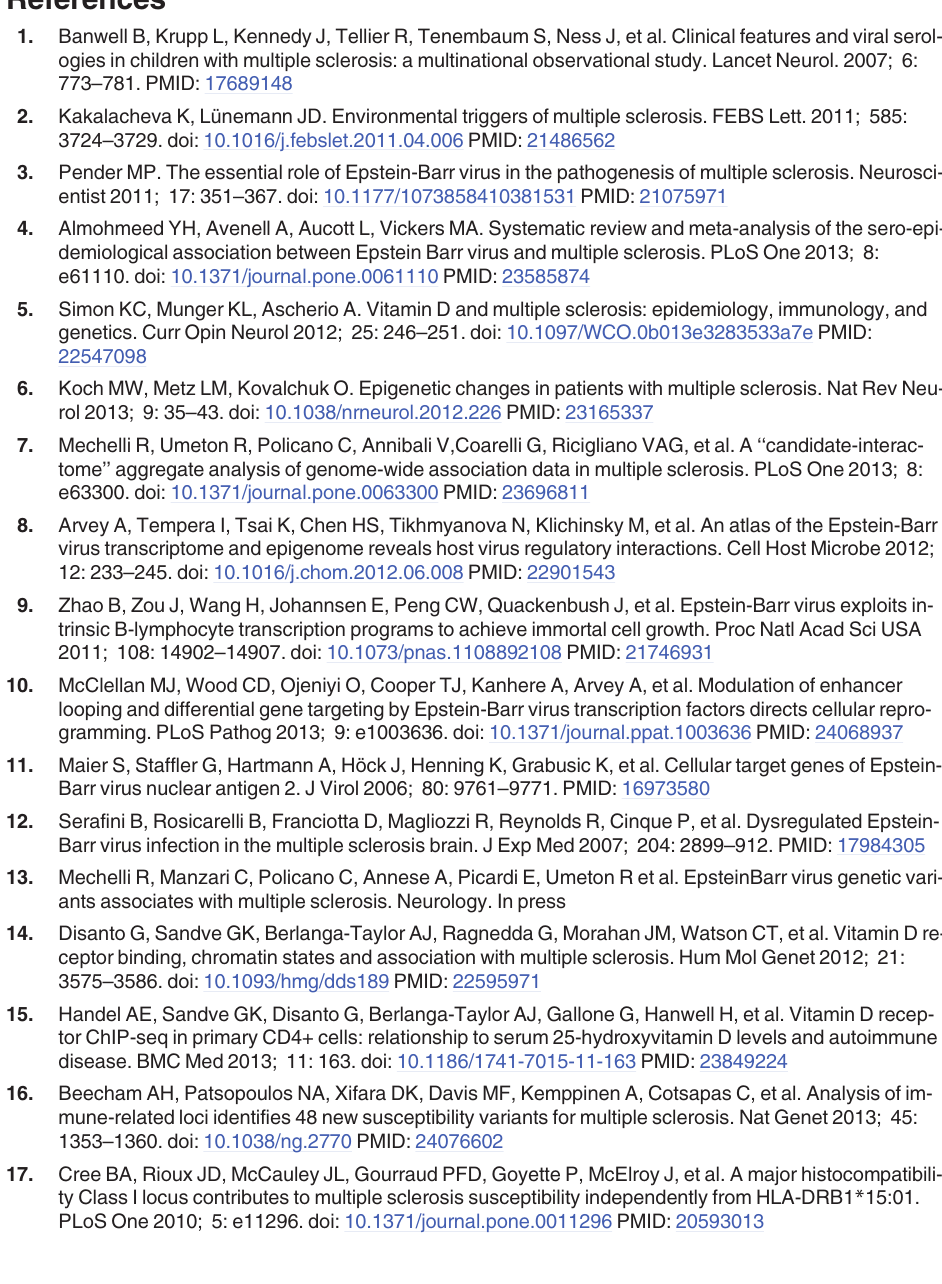
S5 Table. Prediction of function for genomic regions bound by EBNA2, VDR or by both